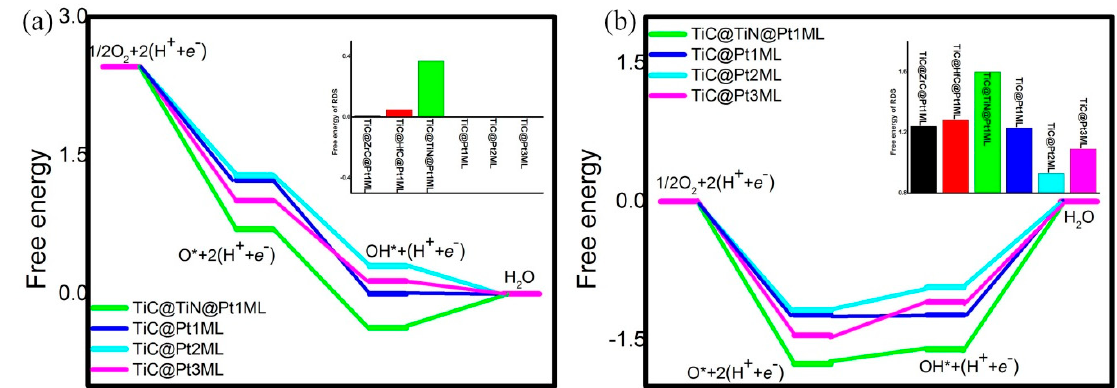
Figure 3. The free energies at the potential of 0 V ( a ) and 1.23 V ( b ). The RDS ∆ G are shown in the insets.